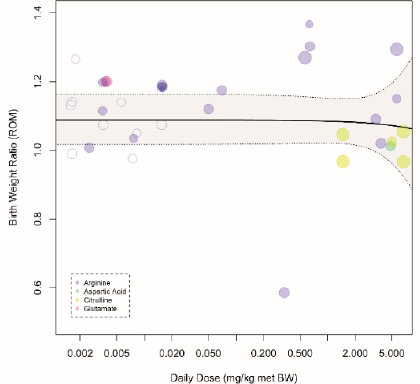
Figure 3. Dose–response curve of prenatal supplementation of the arginine family on fetal / birth weight in complicated pregnancies: Daily dose is expressed as mg per kg metabolic body weight. Open dots indicate human studies, and closed dots indicate animal studies. There is no dose–response relation between prenatal supplementation of amino acids from the arginine family and birth weight ratio ( p slope = 0.81). An increase of 10% was already reached at the lowest dose.